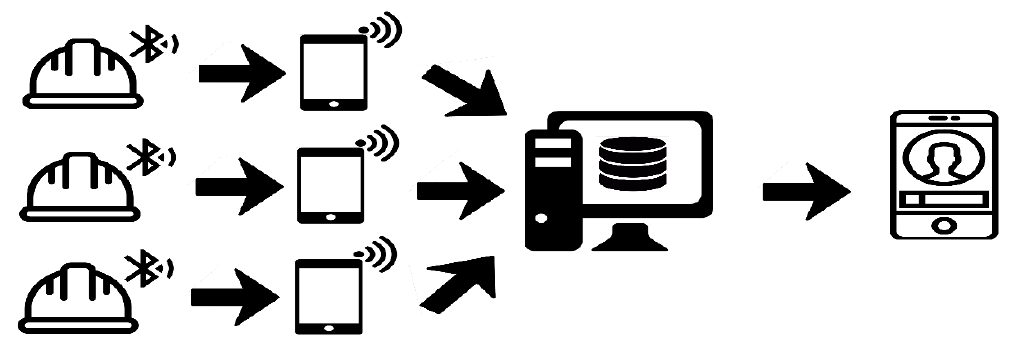
Figure 4. Data transmission in the three-axis accelerometer safety helmet sensing system.